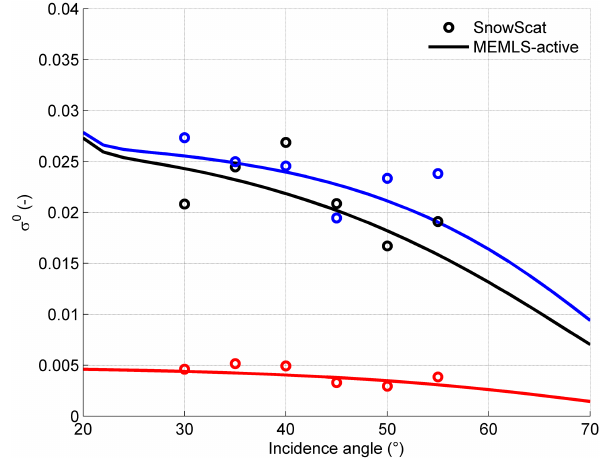
Figure 8. σ 0 at 10.2GHz measured by SnowScat (circles) and mod- eled by MEMLS3&a with CT input (lines). Colors represent polar- ization, with vv – black, hh – blue and hv – red. Best fit parameters according to Fig.